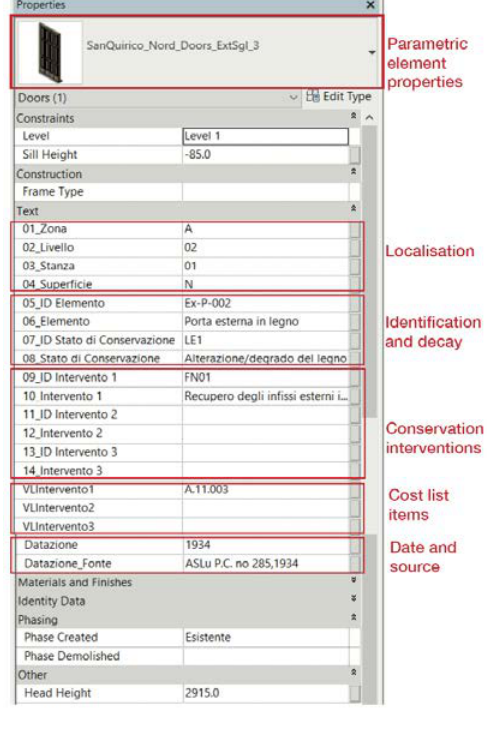
Figure 2. Shared parameters object properties